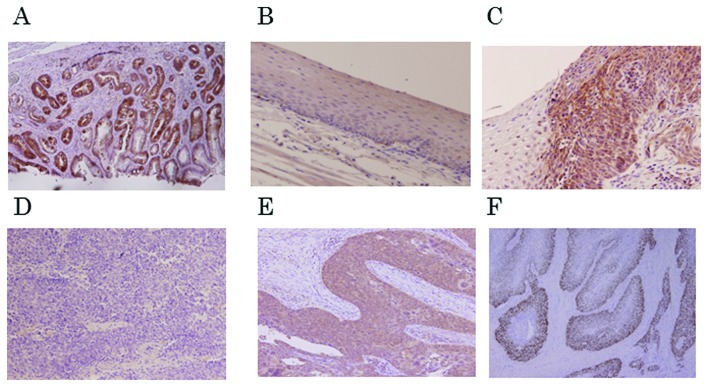
Immunohistochemical analysis of STC1 expression in esophageal cancer. (A) Normal squamous epithelium was negative for STC1 expression. (B) Normal gastric glands showed positive staining for STC1, which was used as a positive control. (C) Positive staining for STC1 in esophageal squamous cell carcinoma (ESCC). (D) Negative staining for STC1 in ESCC. (E) Positive staining for HIF-1α in ESCC. (F) Positive staining for p53 in ESCC. Magnification, ×100.